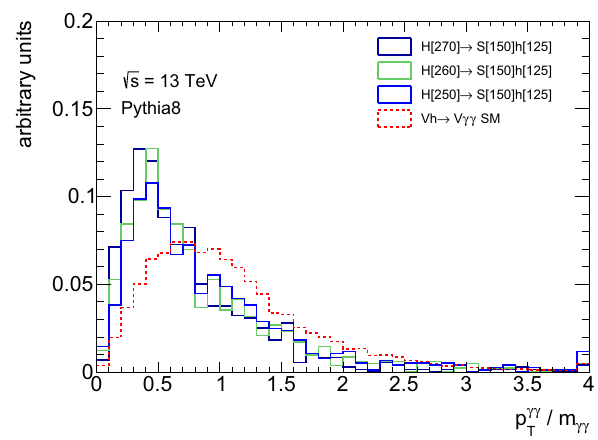
Fig. 5 Dijet invariant mass in events with two photons and at least two jets for several H → Sh samples (solid lines) compared with the SM Vh process with h → γγ (dashed line) generated with PYTHIA8 . The last bin contains overflow events